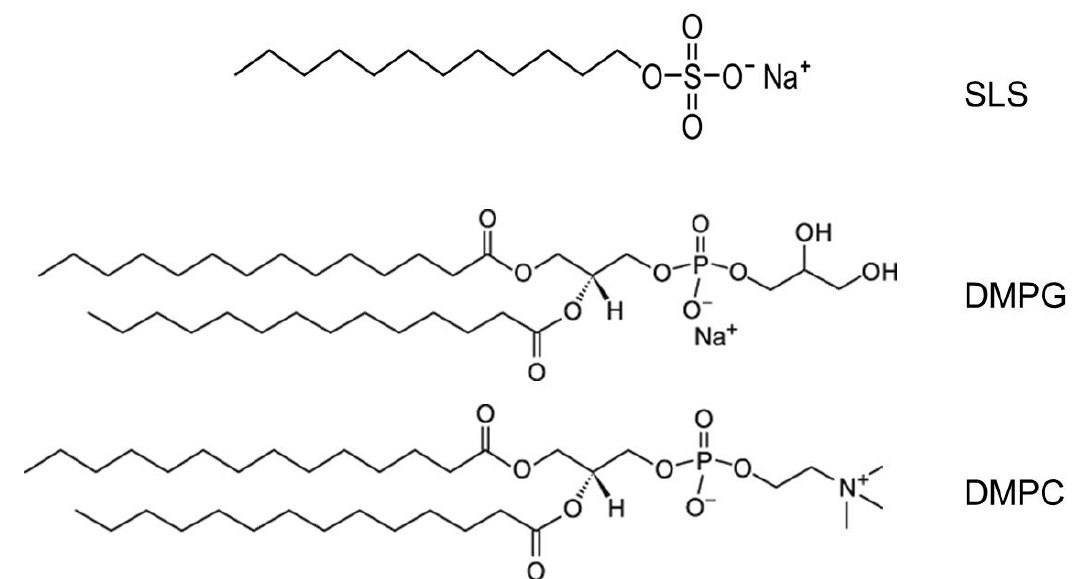
Figure 4. Molecules studied: detergent SLS (sodium dodecyl sulphate) with one HC chain, and phospholipids with two HC chains, charged DMPG and neutral DMPC (item